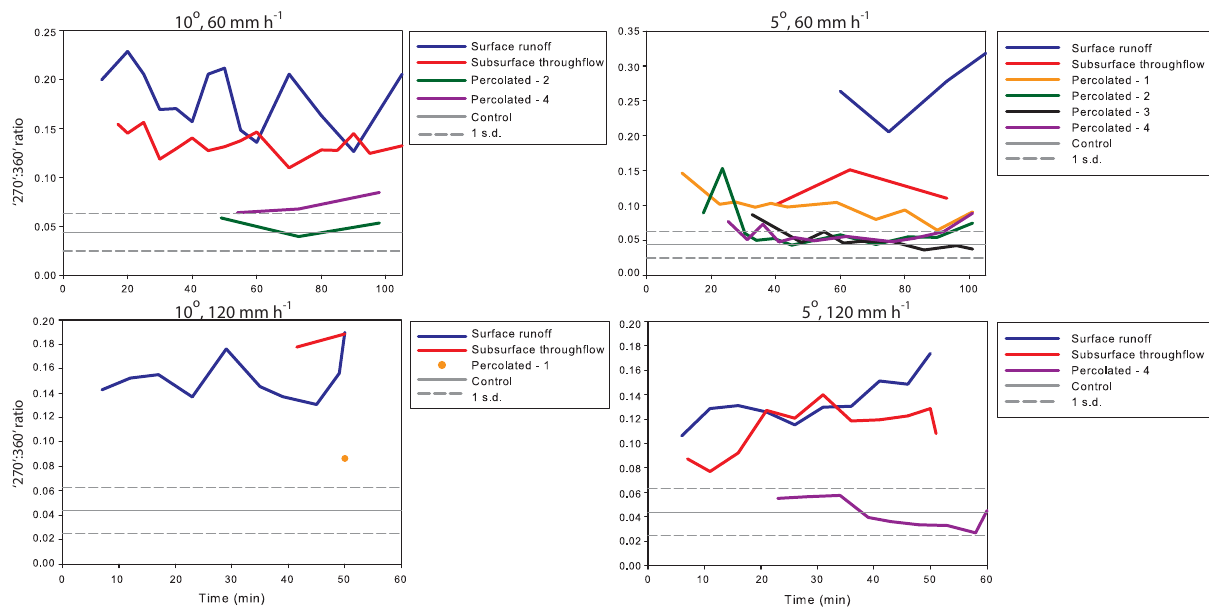
Figure 8. Plots showing the ratio of 270 : 360nm fluorescence intensities for each measured flow pathway. The grey lines represent the average value for the control samples and the grey dashed lines are 1 standard deviation around the